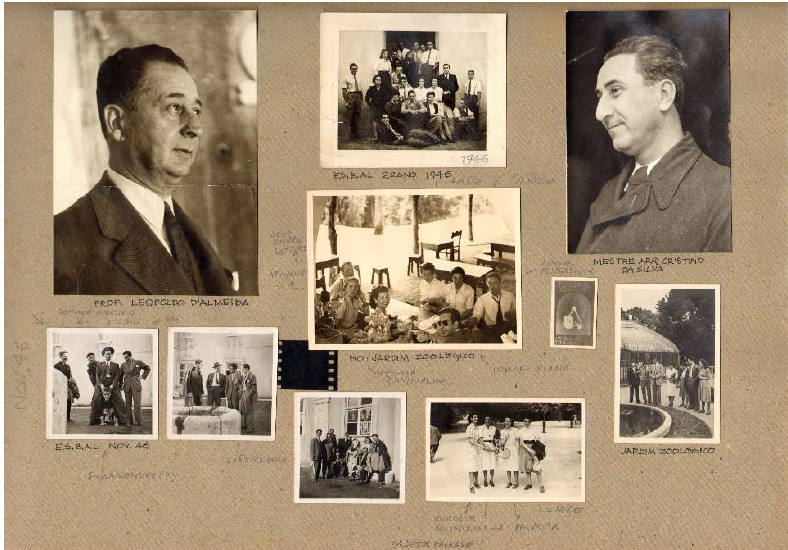
Figure 2. Photo album page containing images of the 1944/1945 class of the Lisbon School of Fine Arts, with Maria Carlota Quintanilha among other female and male colleagues (mostly school fieldtrips in 1946). The two portraits are from the most influential professors of the time in Lisbon: the sculptor Leopoldo de Almeida (1898–1975) and the architect Luís Cristino da Silva (1896–1976). (Credits and courtesy: Leonor Matos Silva on behalf of Maria Antónia Roque Gameiro Martins Barata Pereira Cabral archive).